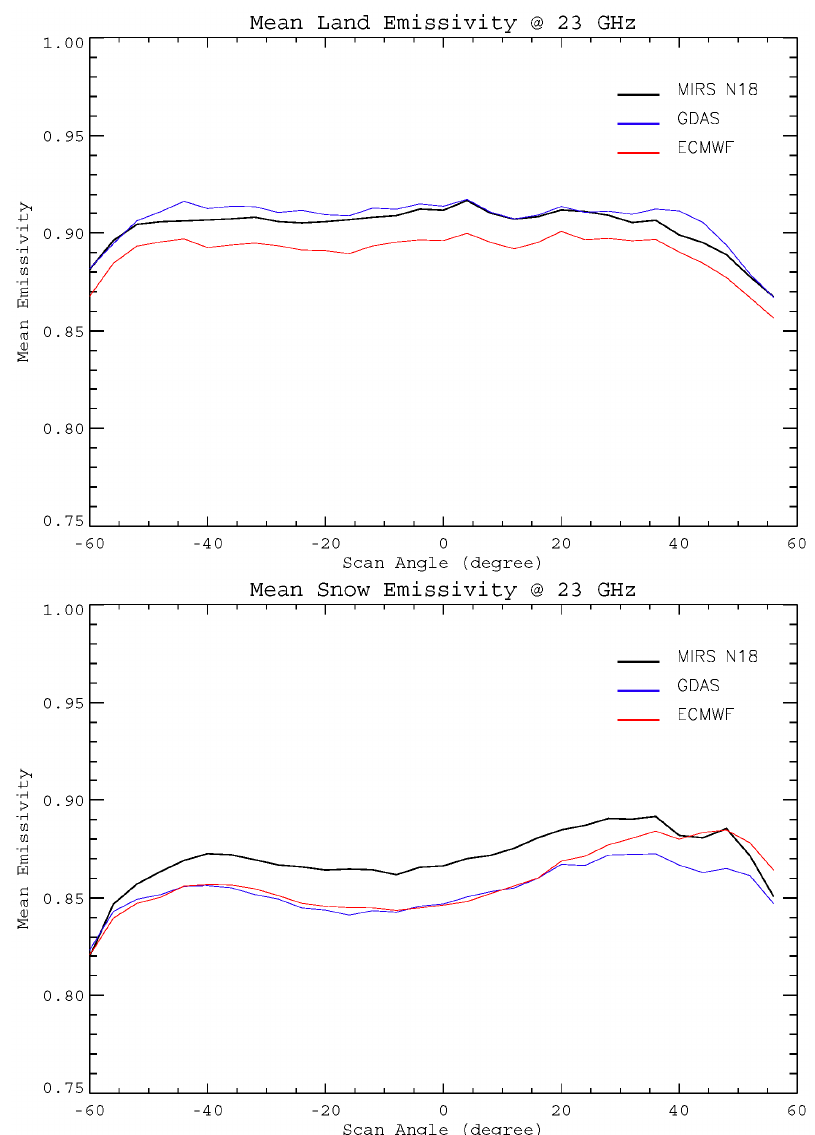
Figure 9. Mean emissivity at 23.8 GHz as a function of scan angle averaged over snow-free land ( top ) and snow-covered land ( bottom ). These correspond to the MiRS NOAA-18 retrieved emissivity, the analytically computed GDAS emissivity, and the analytically computed ECMWF emissivity for 23 January 2010.